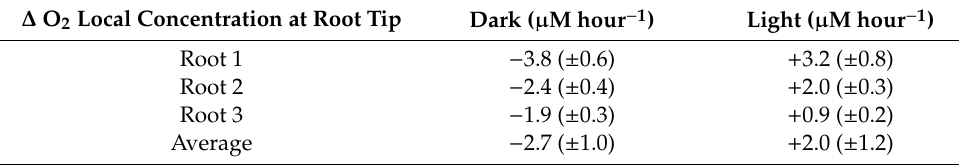
Figure 2. Diurnal changes in local O 2 concentrations at root tips. ( A ) – ( D ) illustrate three root tips and local O 2 concentrations in the range of 0 – 125 µM O 2 represented as color coded pixels. Colored squares 1–3 represent areas around root tips (1.0 cm 2 ) where local O 2 concentrations were quantified at the end of dark (10 h) and light (14 h) incubated cycles, respectively. ( E ) displays averaged measured local O 2 concentrations over time, measured in time intervals of 5 min for each root tip area 1–3, respectively. Table 1. Responses of local root tip O 2 concentrations to diurnal cycles. Changes in local O 2 concentrations ( ∆ O 2 local) at three designated root tips (roots 1–3) and average changes during dark (10 h) and light (14 h) incubation.